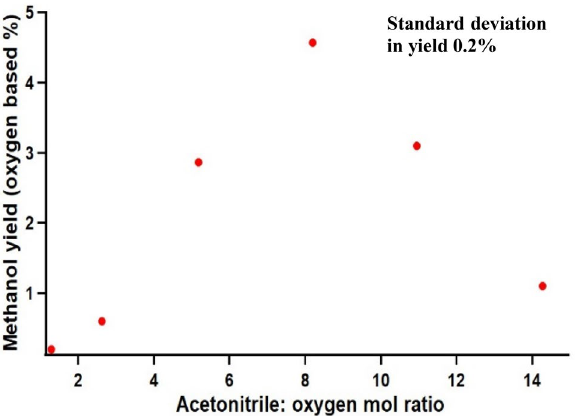
Figure 3. The effect of acetonitrile to oxygen molar ratio on direct methane oxidation to methanol in near supercritical acetonitrile. 9.5–95.7 mmol acetonitrile, − 30 °C cold feed, 163 mmol He, 120–124 mmol methane, 7.3–7.4 mmol of oxygen (without h -BN). All entries were carried out at 275 °C with 2.5 °C/min ramp rate, zero dwell time, and natural cooling to room temperature, 60 rpm stirring speed. Methanol yield was calculated based on the GC peak area calibration plot and reconfirmed with NMR. The standard deviation of the yield was calculated by replicating one experiment with comparison to NMR data.